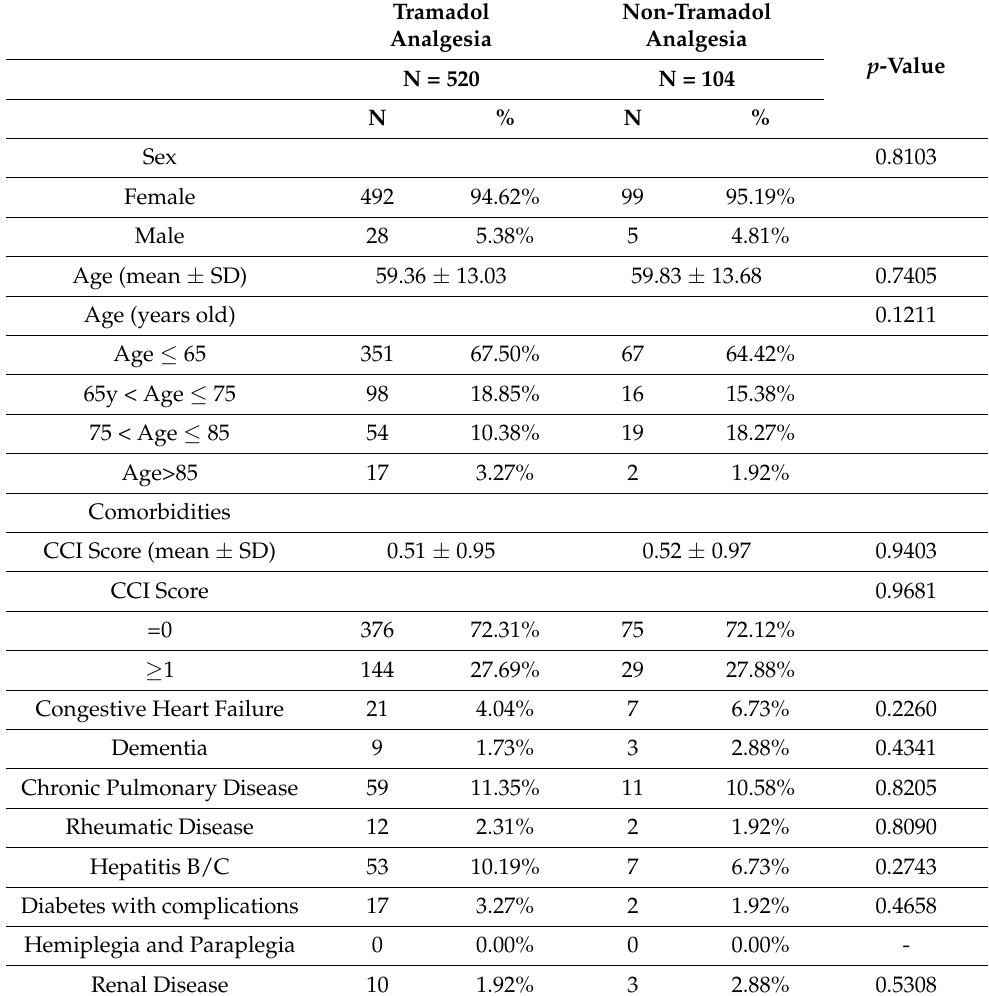
Table 1. Tramadol or non-tramadol analgesic drugs use for chronic pain patients before breast cancer diagnosis after propensity scores